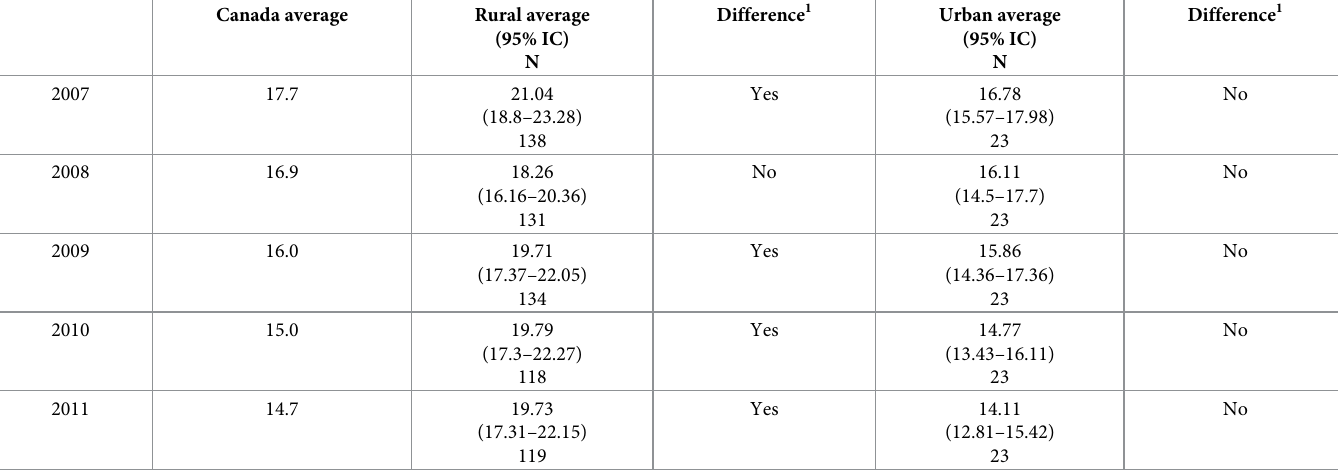
Table 2. Comparison between the 30-day stroke in-hospital mortality rates for each year with the Canada average. Canada